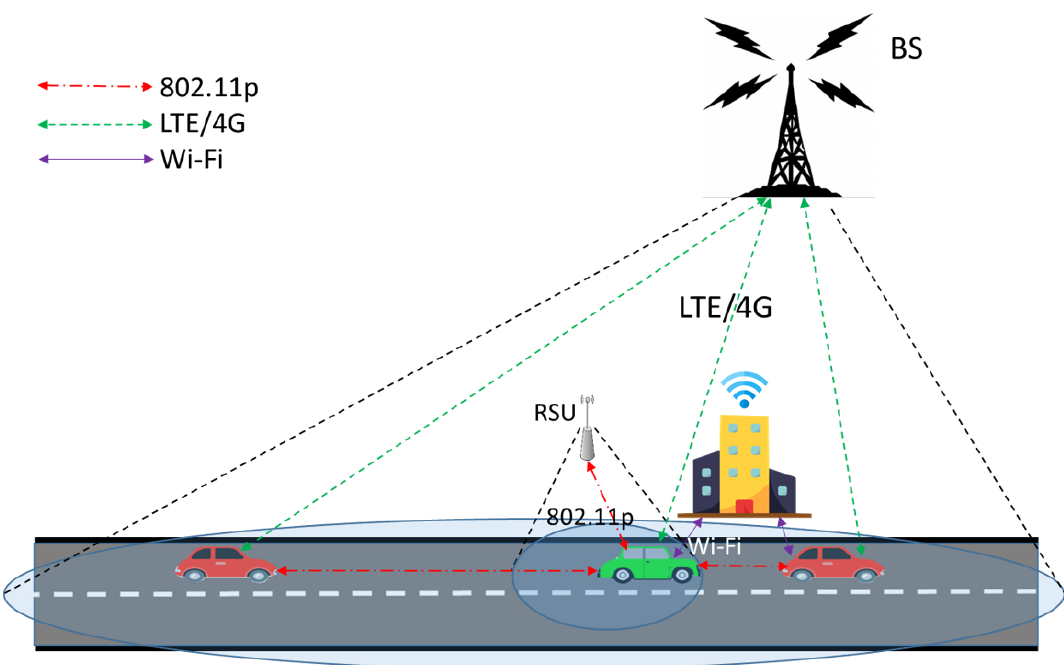
Figure 4. MPTCP in vehicular